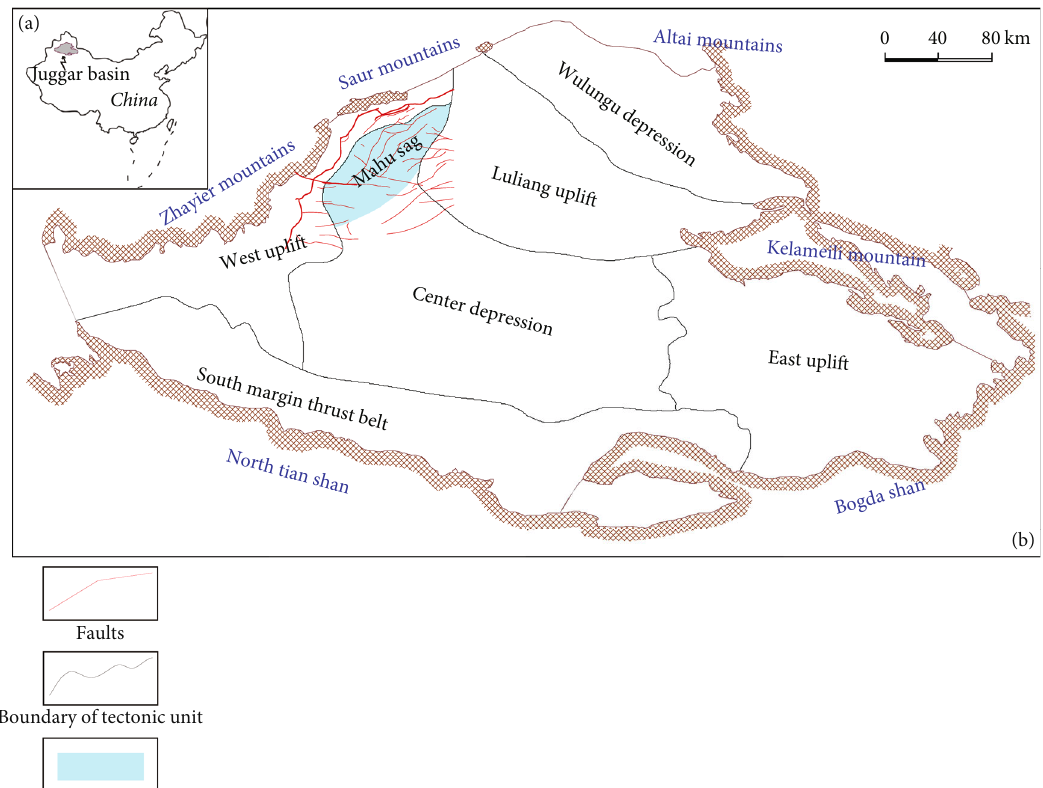
Figure 1: (a) Shows the location of the Junggar Basin in China; (b) shows the structure units around and the internal units in the Junggar Basin.